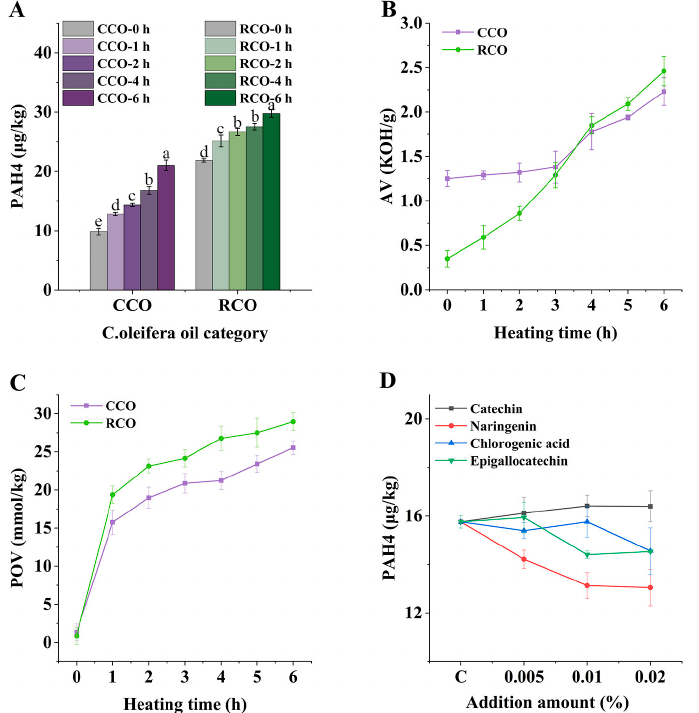
Figure 1. Changes of PAH4 in CCO and RCO heating for 6 h ( A ); The AV and POV changes of CCO and RCO during heating for 6 h ( B , C ); Effects of different addition of catechin, naringin, chlorogenic acid, and epigallocatechin on the formation of PAH4 in C. oleifera oil after heated at 180 °C ( D ). Bars with different letters show significant differences ( p < 0.05).